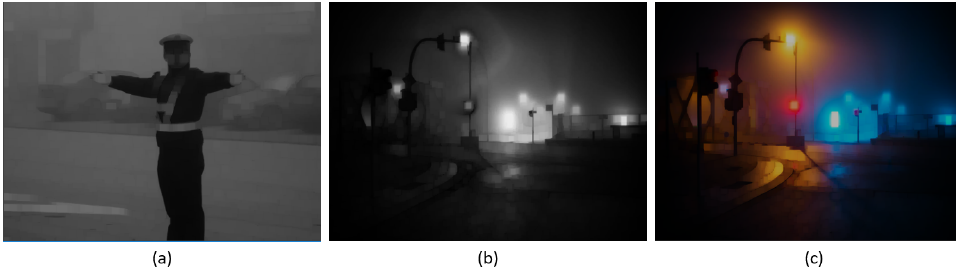
Figure 9. Atmospheric veils before the refinement step: ( a ) atmospheric veil estimation of a white fog image, ( b ) atmospheric veil estimation of a colored foggy image from the color channel with the minimum intensity, ( c ) atmospheric veil estimation of a colored foggy image from each color channel (adapted with permission from ref. [35]. Copyright 2021 Mark